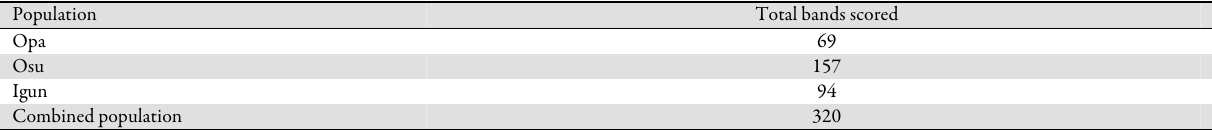
Table 3. Total bands scored in each population